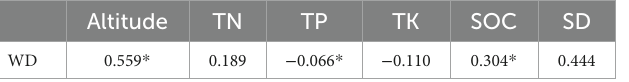
TABLE 4 Correlation analysis between wood density and environmental factors